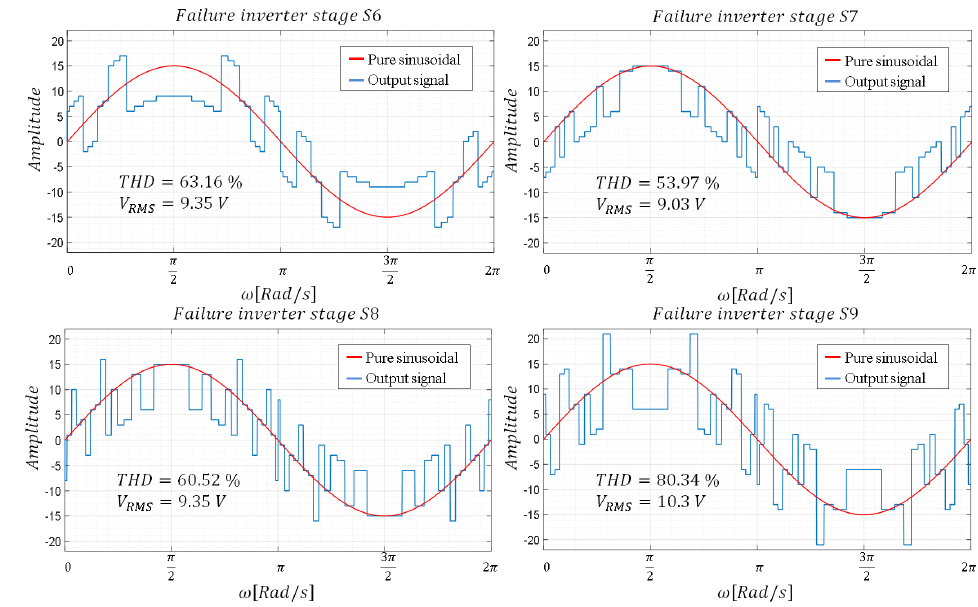
Figure 4. Output waveforms for a failure in one of the inverter stages (short circuit).